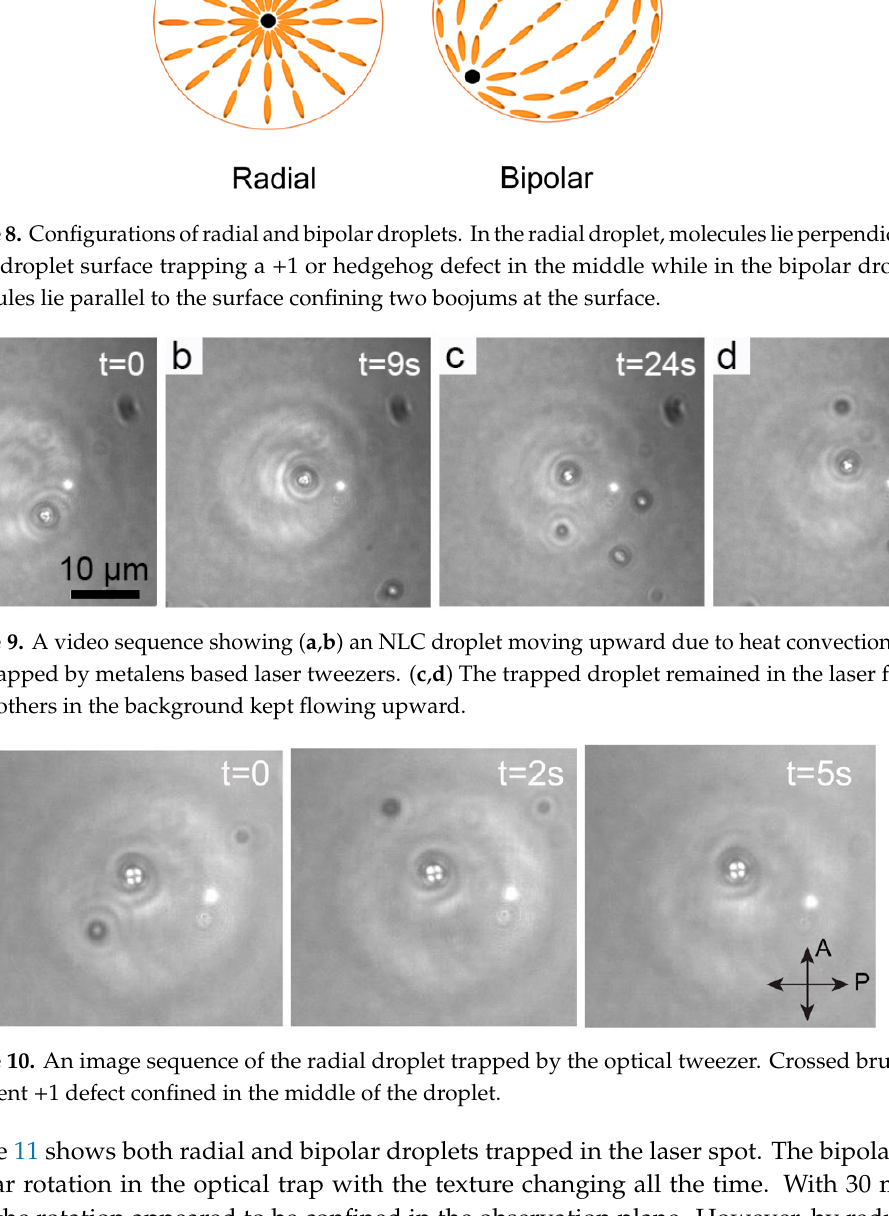
Figure 7. The variance measurement of the bead position as a function of laser modulation frequency.